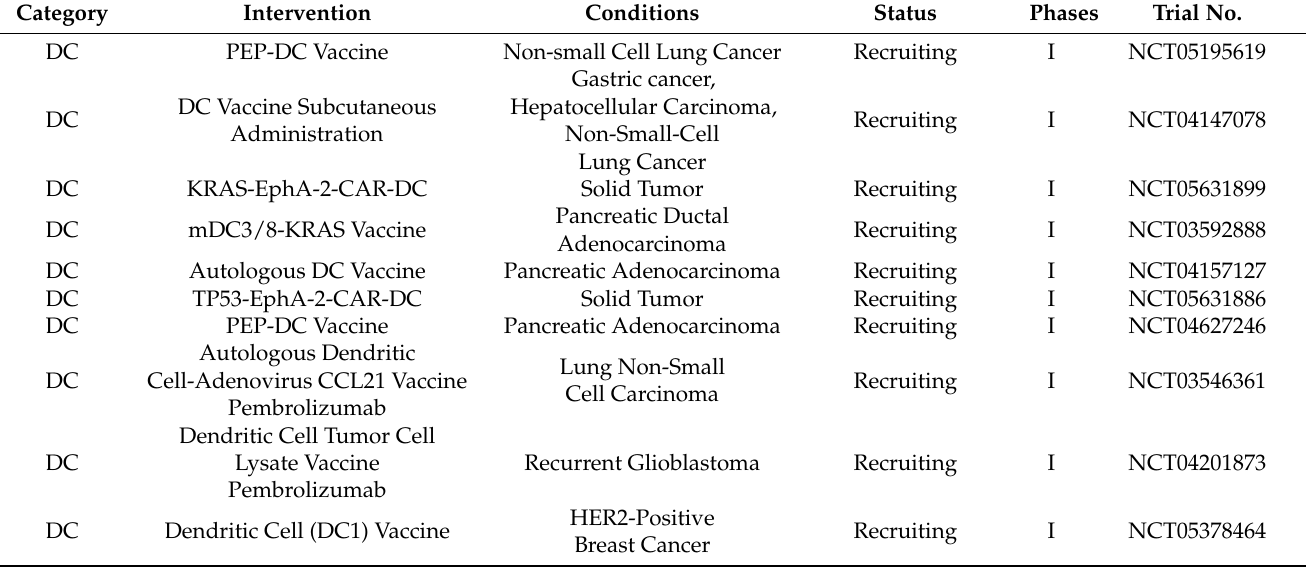
Table 1. DC-based cancer vaccines in clinical